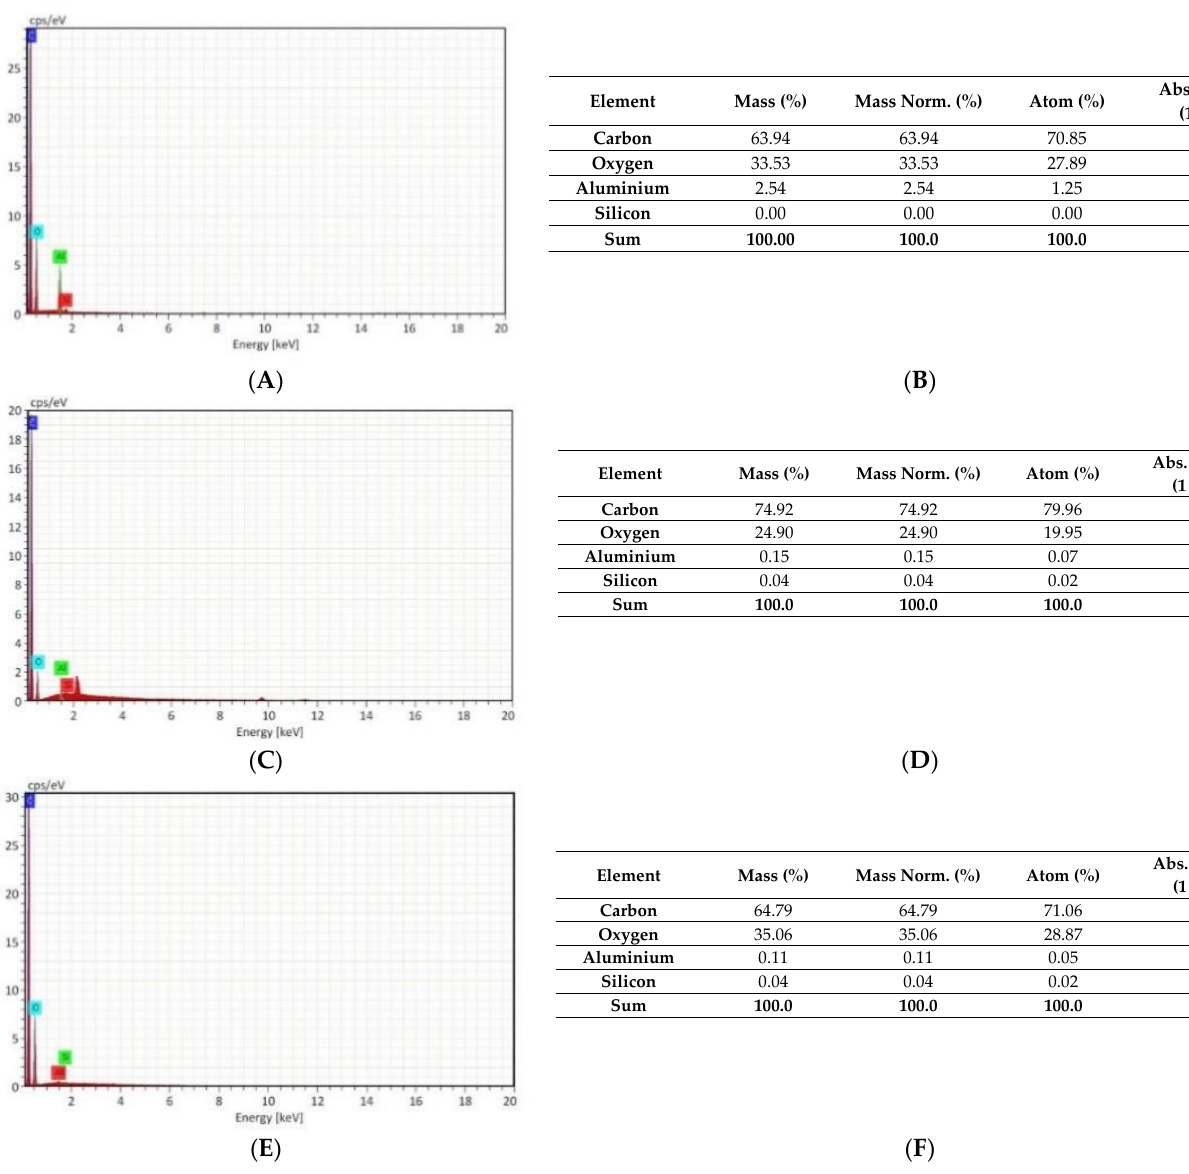
Figure 1. Energy dispersive X-ray spectroscopy (EDX) mapping of the elements carbon, oxygen, silicon, and aluminum: ( A ) Energy dispersive X-ray spectroscopy of virgin PET, ( B ) elemental analysis of virgin PET, ( C ) energy dispersive X-ray spectroscopy of PET bottle, ( D ) elemental analysis of PET bottle, ( E ) energy dispersive X-ray spectroscopy of PET20% and ( F ) elemental analysis of PET20%.